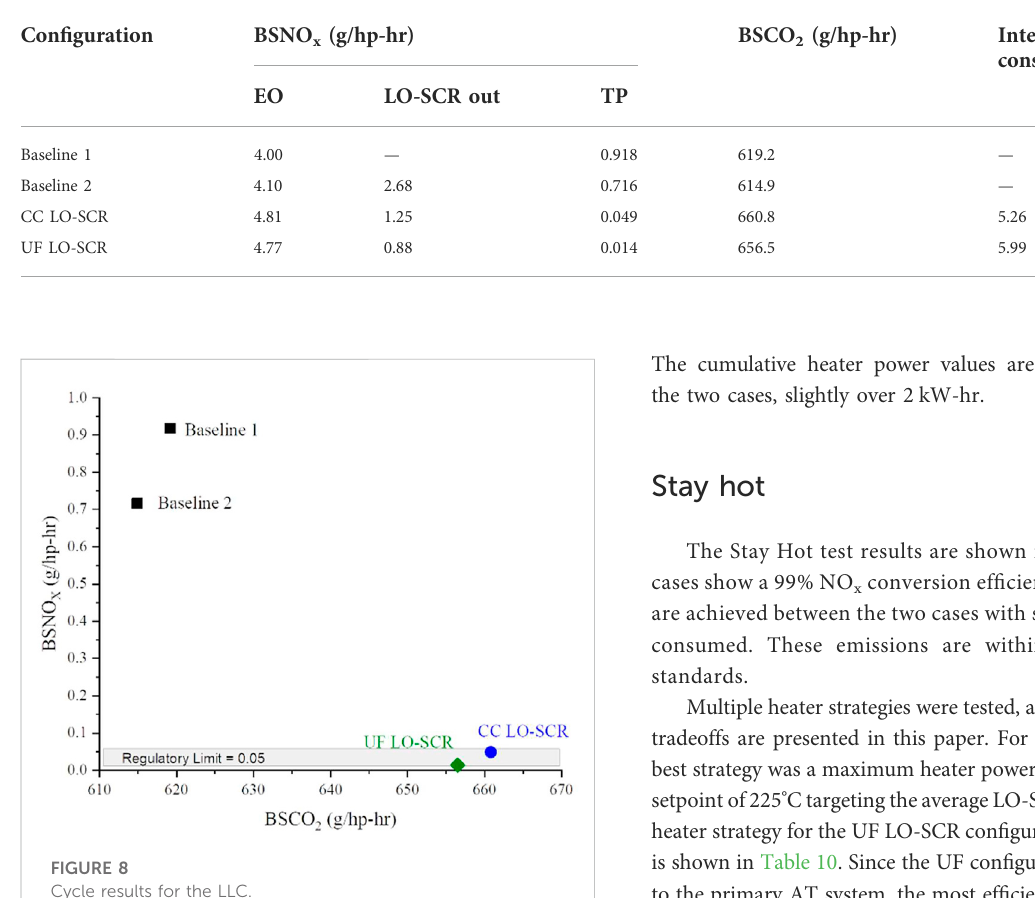
FIGURE 8 Cycle results for the